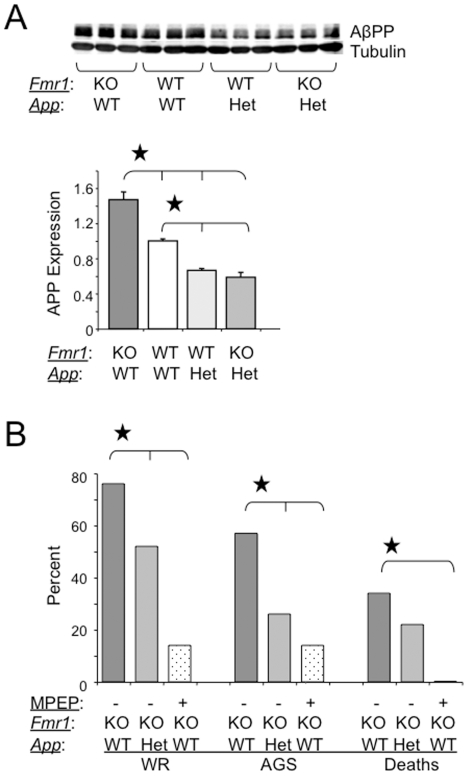
AGS are rescued by genetic manipulation of App or mGluR5 blockade.(A) western blot analyses of AβPP levels in Fmr1KO, WT, AppHE
T and Fmr1KO/AppHET mice (n = 3 male mice per strain, 1 month old). Statistics: one-way ANOVA p<0.0001, F = 53.95. Stars (★) denote statistically different levels by Student T-test analyses and by Bonferroni's multiple comparison test (p<0.05). Error bars represent SEM. (B) Assessment of WR, AGS and death rates in Fmr1KO mice (age P21, n = 58)) after genetic manipulation of AβPP levels (n = 23) or treatment with MPEP (n = 14). Stars (★) denote rates that are statistically different from untreated mice (p<0.5) by Fisher exact tests.